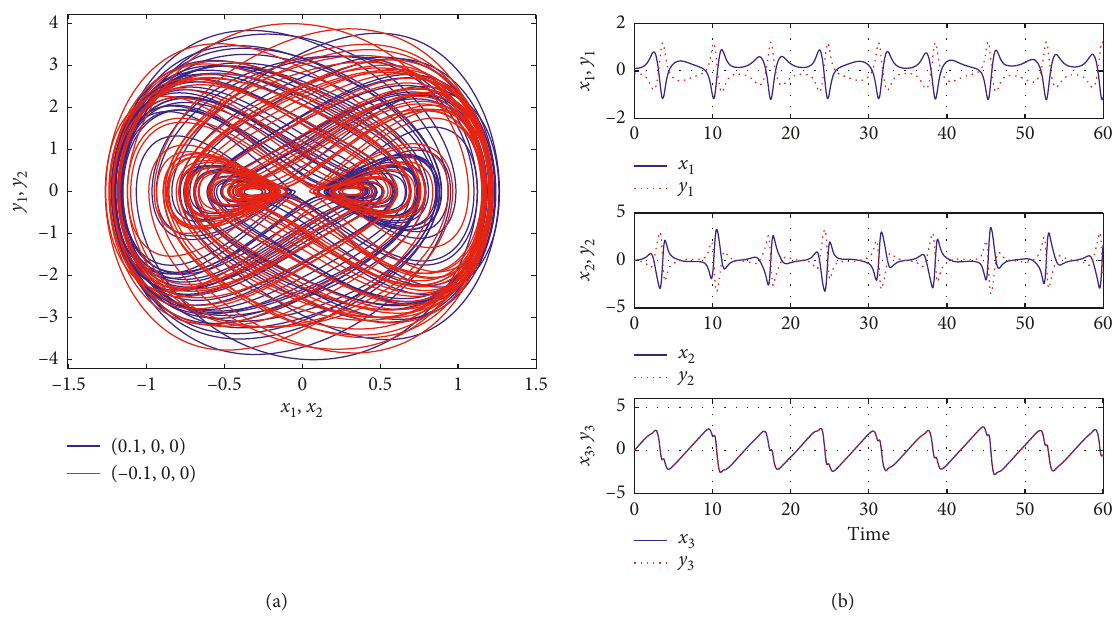
Figure 10: (a) Phase diagram and (b) state trajectories with x ( 0 ) � ( 0 . 1 , 0 , 0 ) and y ( 0 ) � (− 0 . 1 , 0 , 0 ) .